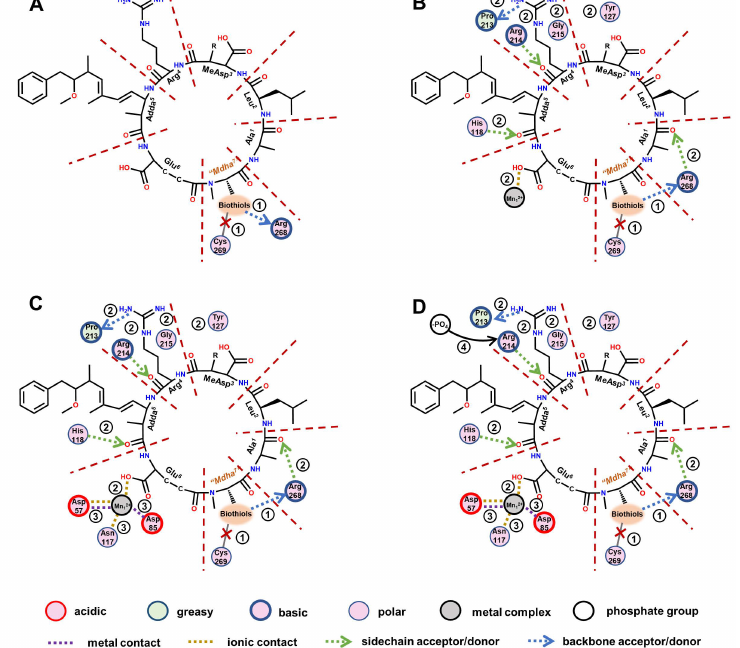
Figure 7. The two-dimensional ligand–receptor interaction diagram for the combination of the toxins to PP2A. The direct influence of the introduced biothiols on the interactions between the toxins and PP2A ( A ). The influence of the changed “Mdha 7 ” on the interactions between the toxins and the PP2A ( B ). The influence of the weakening combination of the toxins to PP2A on the interactions involving Mn 2+ ions ( C ). The influence of the changed interactions on the exposure of amino acids bound to a phosphate group ( D